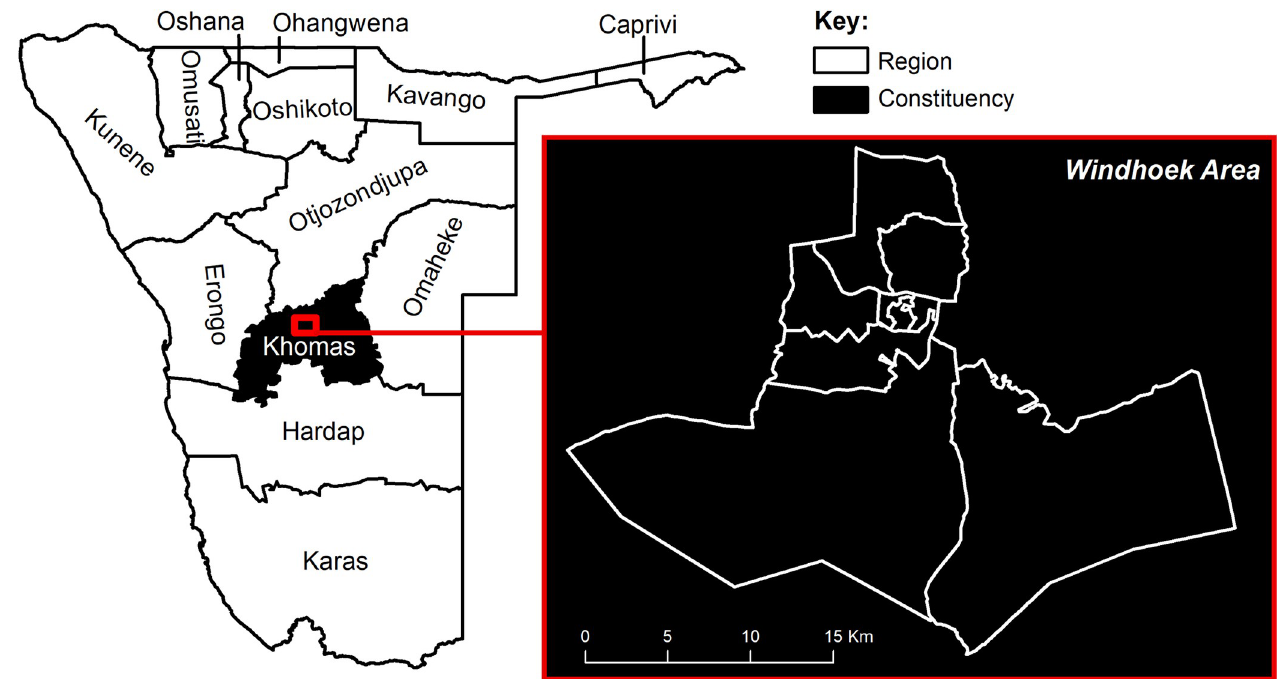
Fig 1. Location of Khomas region in Namibia, and of constituencies in Windhoek area. Source: Constituency boundaries publically available from https:// gadm.org/.